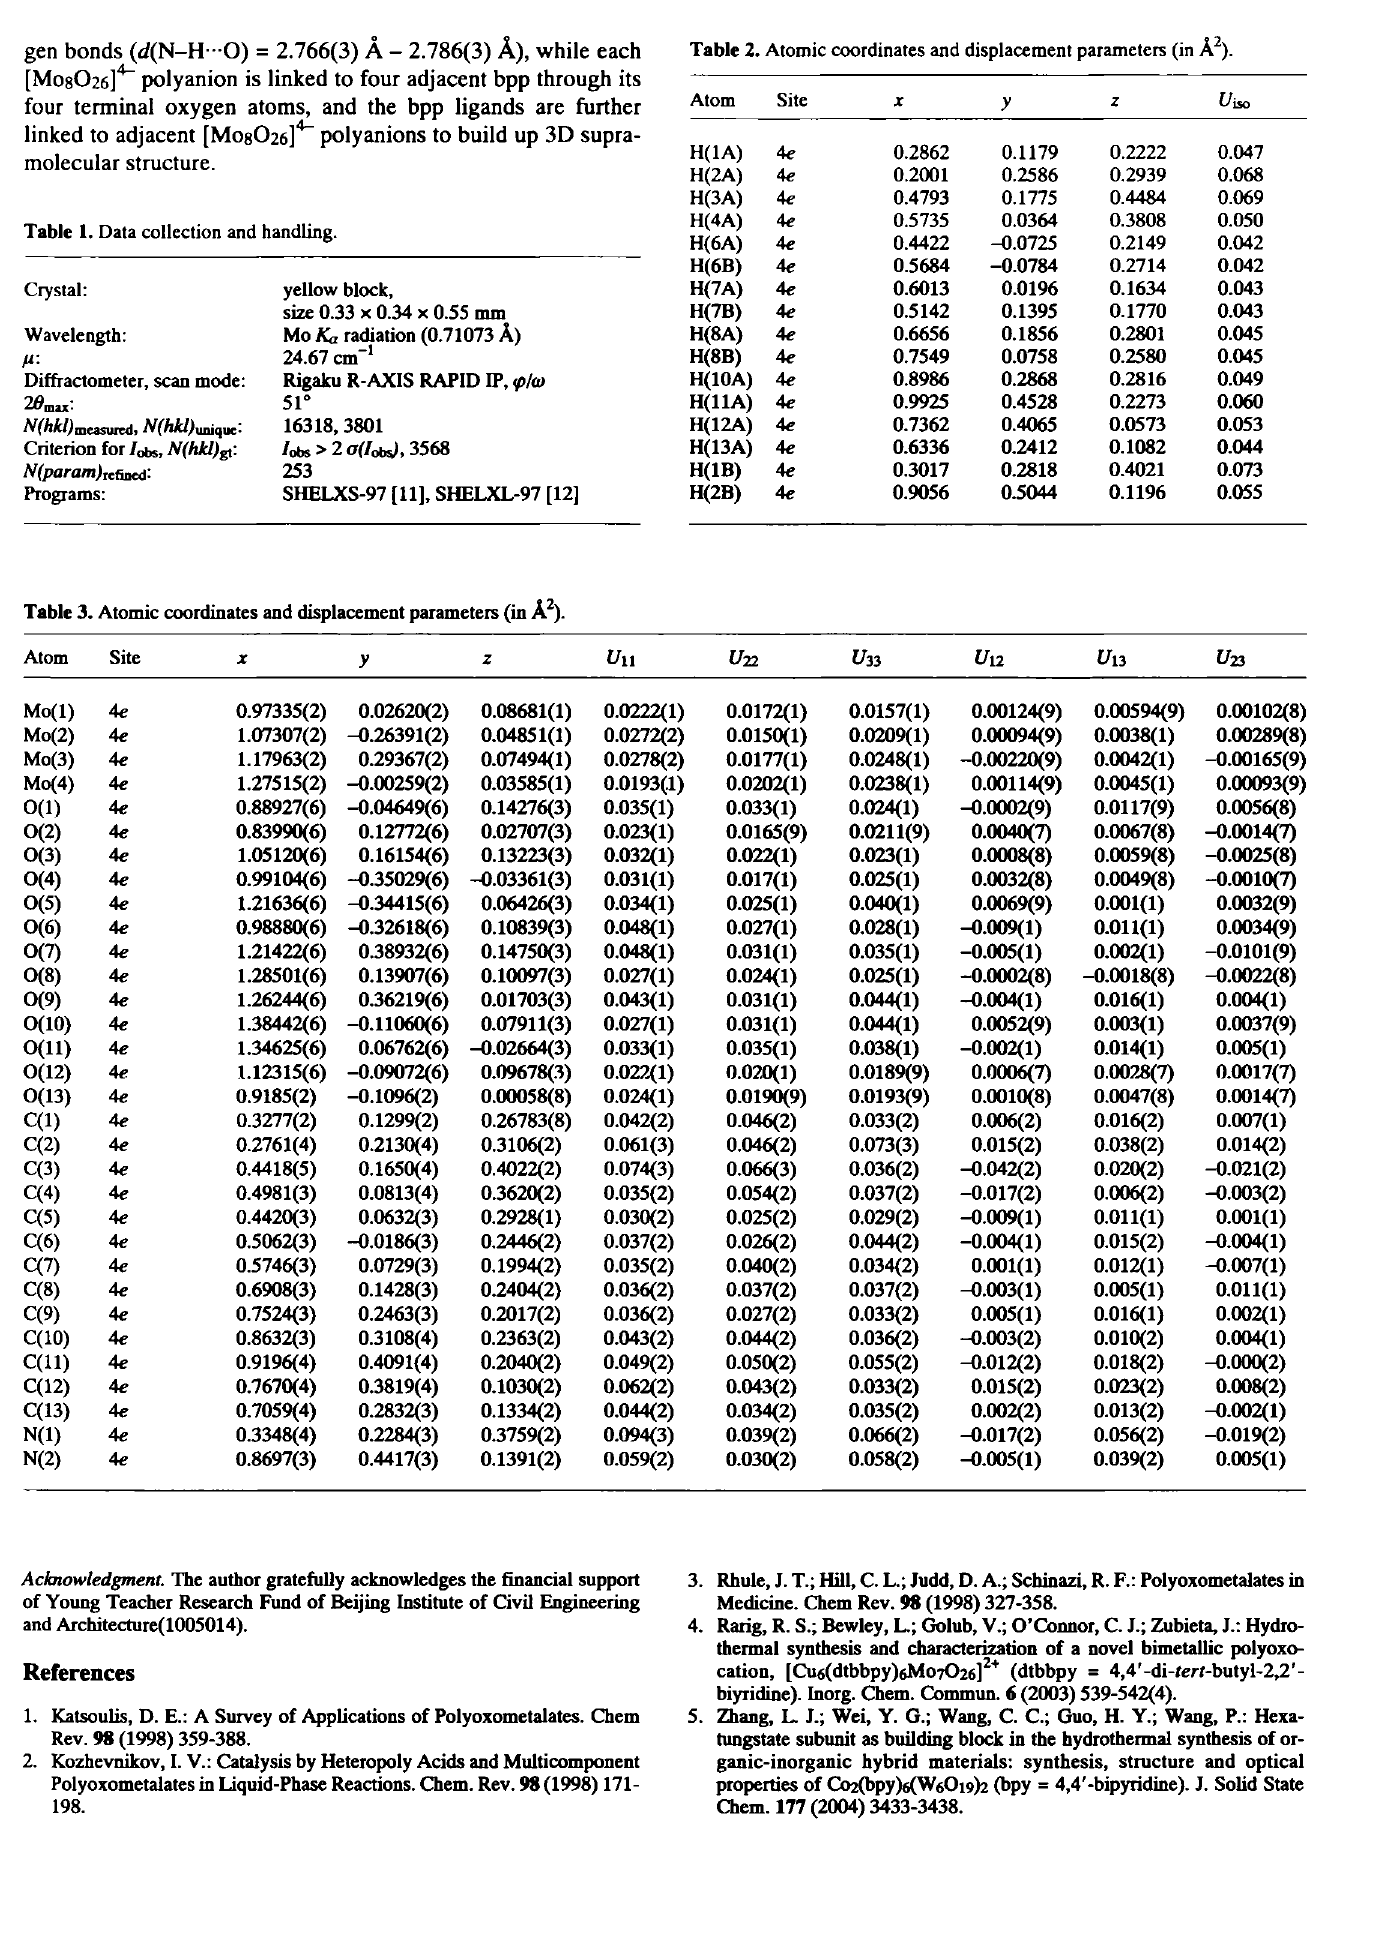
Table 2. Atomic coordinates and displacement parameters (in Ä 2 ).